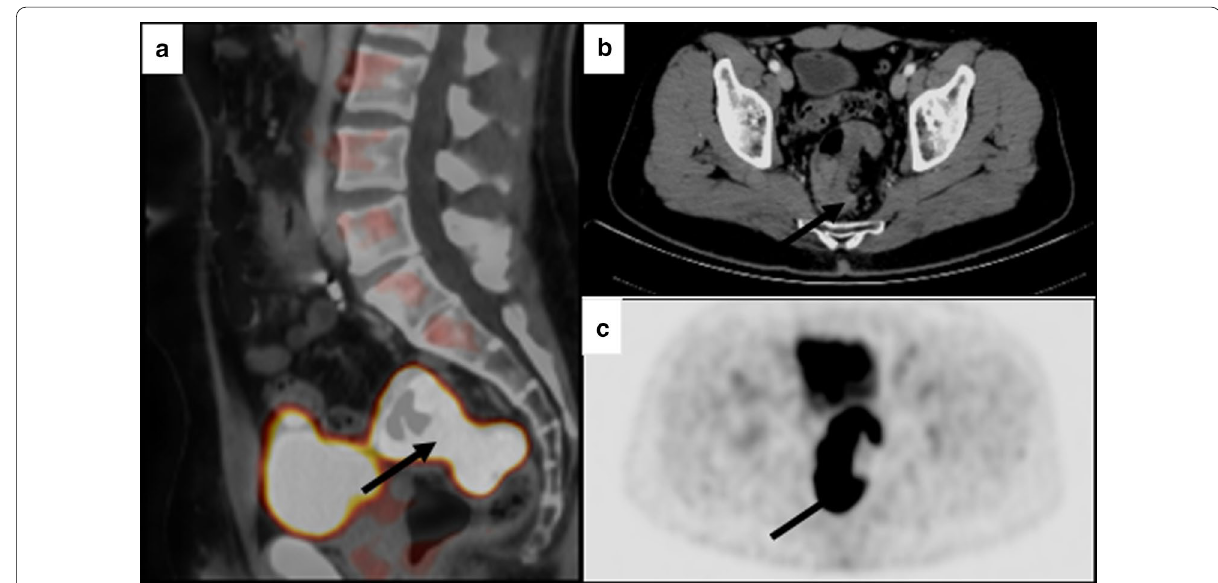
Fig. 3 44-year-old male patient with recently diagnosed rectal cancer, histopathological proven adenocarcinoma grade III. Sagittal fused PET/ CT of pelvis ( a) , Axial CT of the pelvis ( b ), axial PET of the pelvis ( c ) show irregular polypoidal hypermetabolic mass involving upper rectum [black arrows] with SUVmax of 23.68, MTV of 36.35 cm 3 , and TLG of 528.89 g/ml*